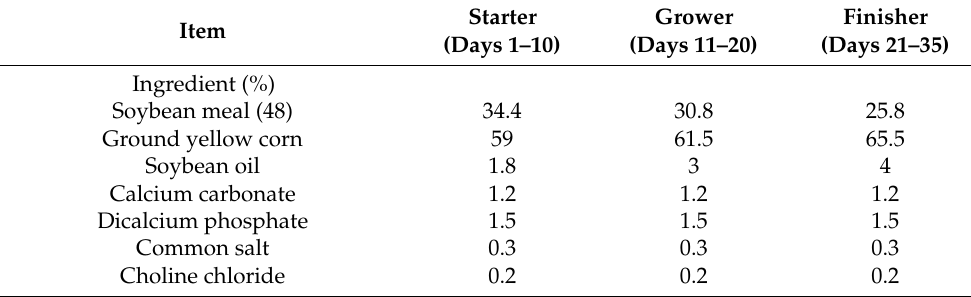
Table 1. The ingredients of basal diets and nutrient